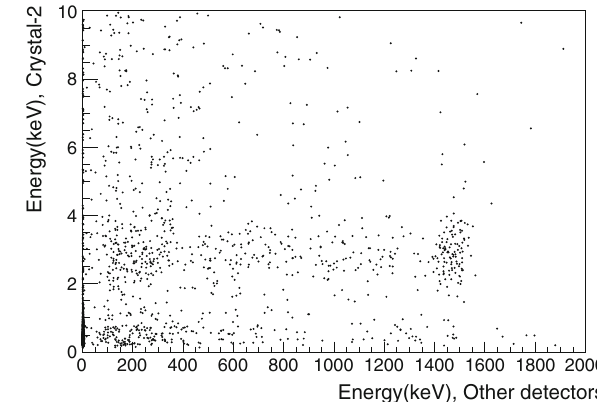
Fig. 21 Charge-weighted mean time (horizontal) versus energy (ver- tical) for Crystal-6. The island of events with low mean time and high energies is due to α -induced events and is well separated from β -/ γ - ray-induced events. Due to quenching effects, the measured α -energy is lower than its full energy